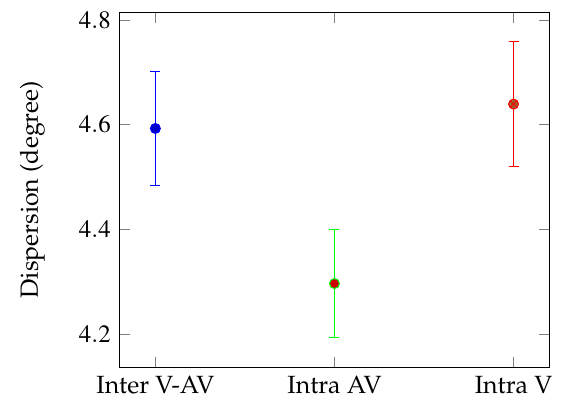
Figure 2 . Mean dispersion values: between all eye positions (blue), between eye positions recorded in audio-visual con- dition (green) and between eye positions recorded in visual condition (red). Dispersions are given in visual angle (de- grees) with error bars corresponding to standard errors.